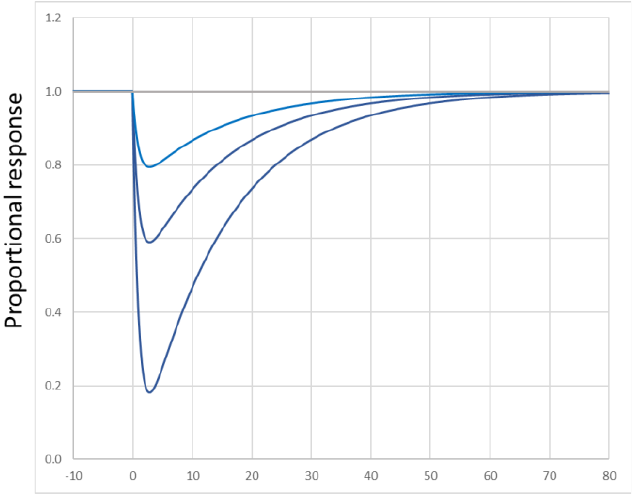
Figure 3: Different combinations of amplitude of response and rate of recovery can give the same duration of response to an environmental